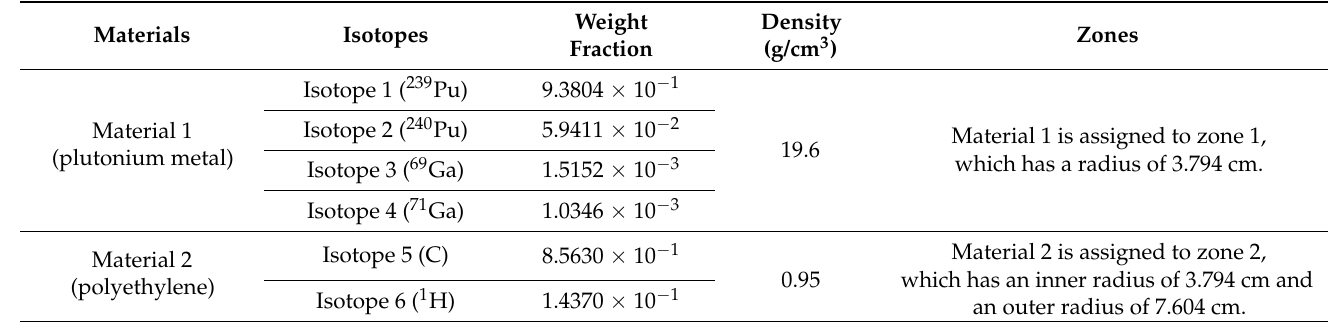
Table 1. Dimensions and material composition of the PERP benchmark.